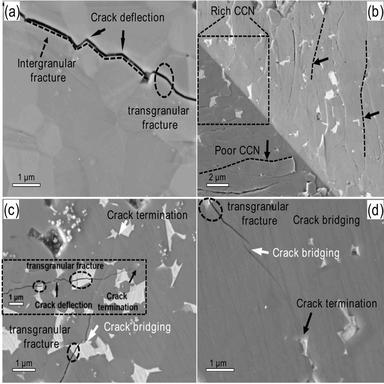
Crack propagation of SiC and CCN/SiC composite: (a) SiC; (b-d) CCN/SiC composite.